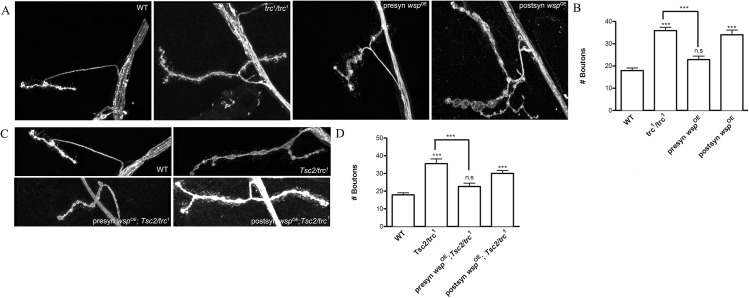
Presynaptic, but not postsynaptic, overexpression of wasp rescues the increase in synaptic boutons observed in trc
1 mutants and trc
1/Tsc2 transheterozygotes.
A) Representative confocal images of the wild type (WT), trc
1 mutants and trc
1 mutants overexpressing WASP either presynaptically (presyn wsp
OE) using BG380.Gal4 or postsynaptically (postsyn wsp
OE) using G7.Gal4 driver. B. Quantification of genotypes in A followed by One-way ANOVA plus Tukey post-hoc test. ***p<0.001 and n.s = not significant. C. Representative confocal images of the wild type (WT), Tsc2/trc
1 transheterozygotes and Tsc2/trc
1 transheterozygotes overexpressing UAS-wasp transgene either presynaptically (presyn wasp
OE; Tsc2/trc
1) when crossed to BG380.Gal4 driver or postsynaptically (postsyn wasp
OE) using G7.Gal4 driver, stained by anti-HRP antibody. D. Quantification of bouton numbers of genotypes in C. One-way ANOVA followed by Tukey’s post-hoc test was performed. ***p<0.001 and n.s indicates “not significant”.